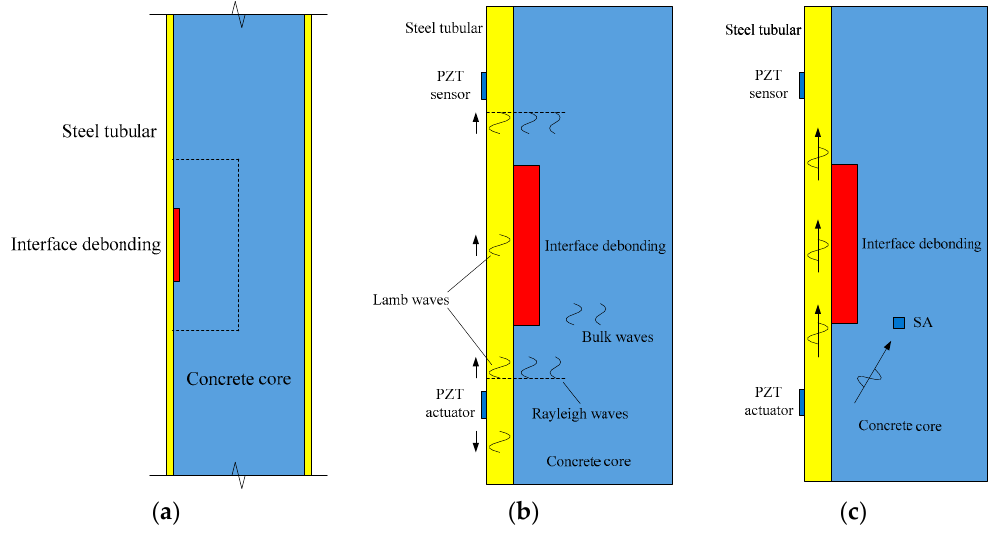
Figure 1. Concept of debonding detection using surface wave measurement for a concrete-filled steel tube (CFST) member. ( a ) CFSTs with interface debonding; ( b ) wave propagation in CFST; ( c ) arrangement of piezoelectric lead zirconate titanate (PZT) patches.